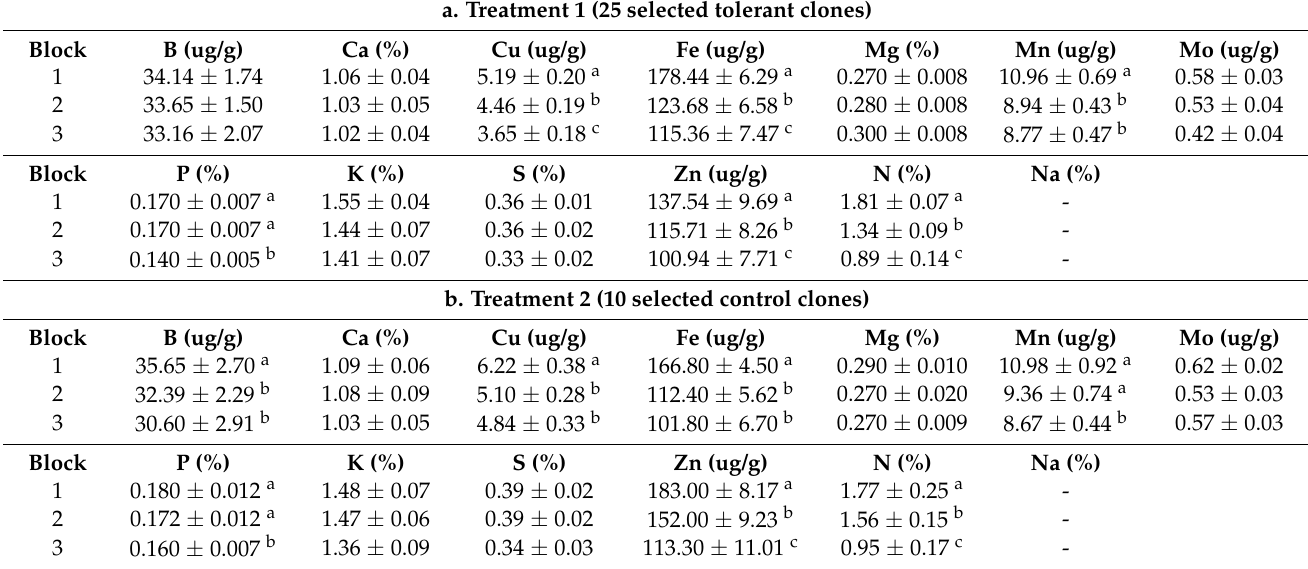
Table 7. Block means of tissue nutrient analysis for each treatment in two-year-old balsam poplar trees. Significant differ- ences between block means at p ≤ 0.05 are indicated by different letters. Block 1 = 5 m from the lake edge; Block 2 = 10 m from the lake edge; Block 3 = 15 m from the lake